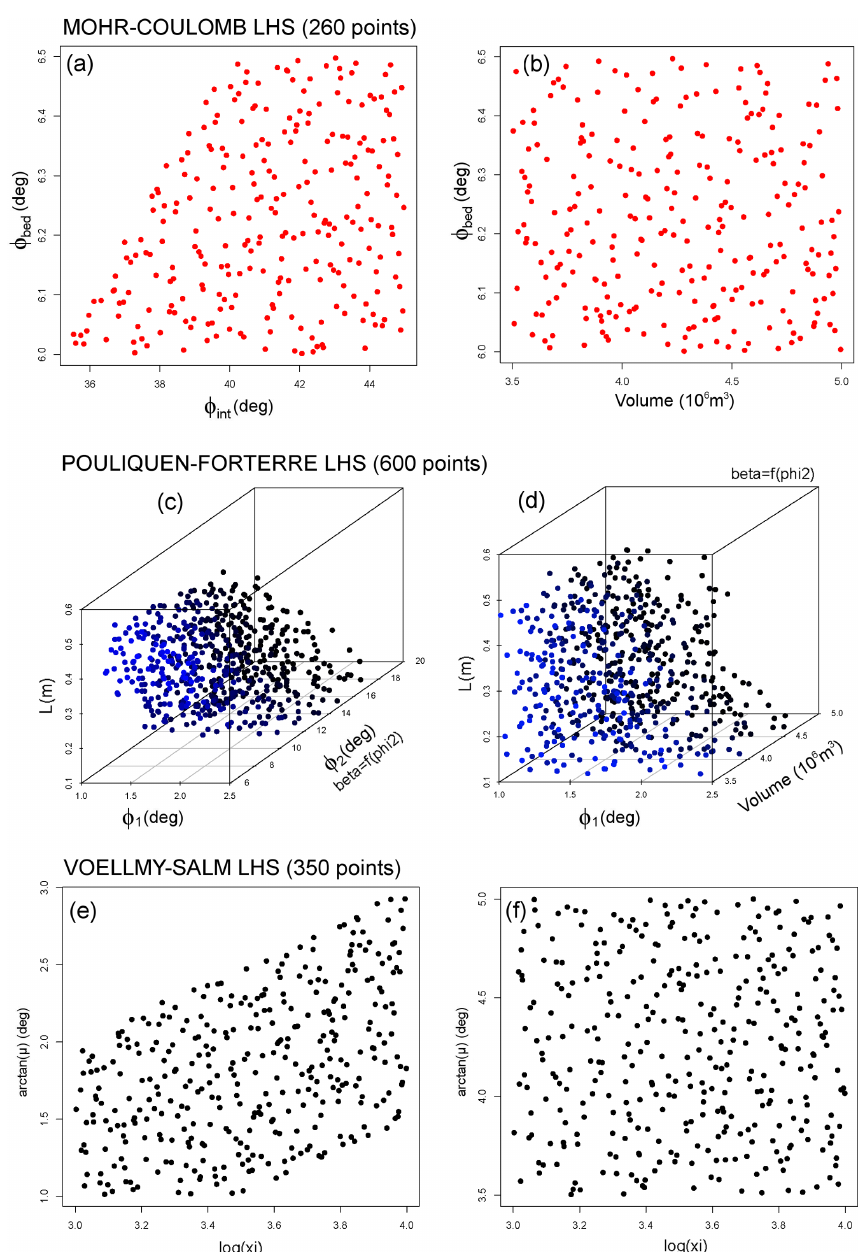
Figure 4. Overview of the specialized experimental design in (a, b) MC, (c, d) PF, and (e, f) VS models. Panels (a, c, e) are projected along the V coordinate, and (b, d, f) are projected the along φ int , φ 2 , and ξ coordinates. In (c, d) , the color expresses the distance along the third